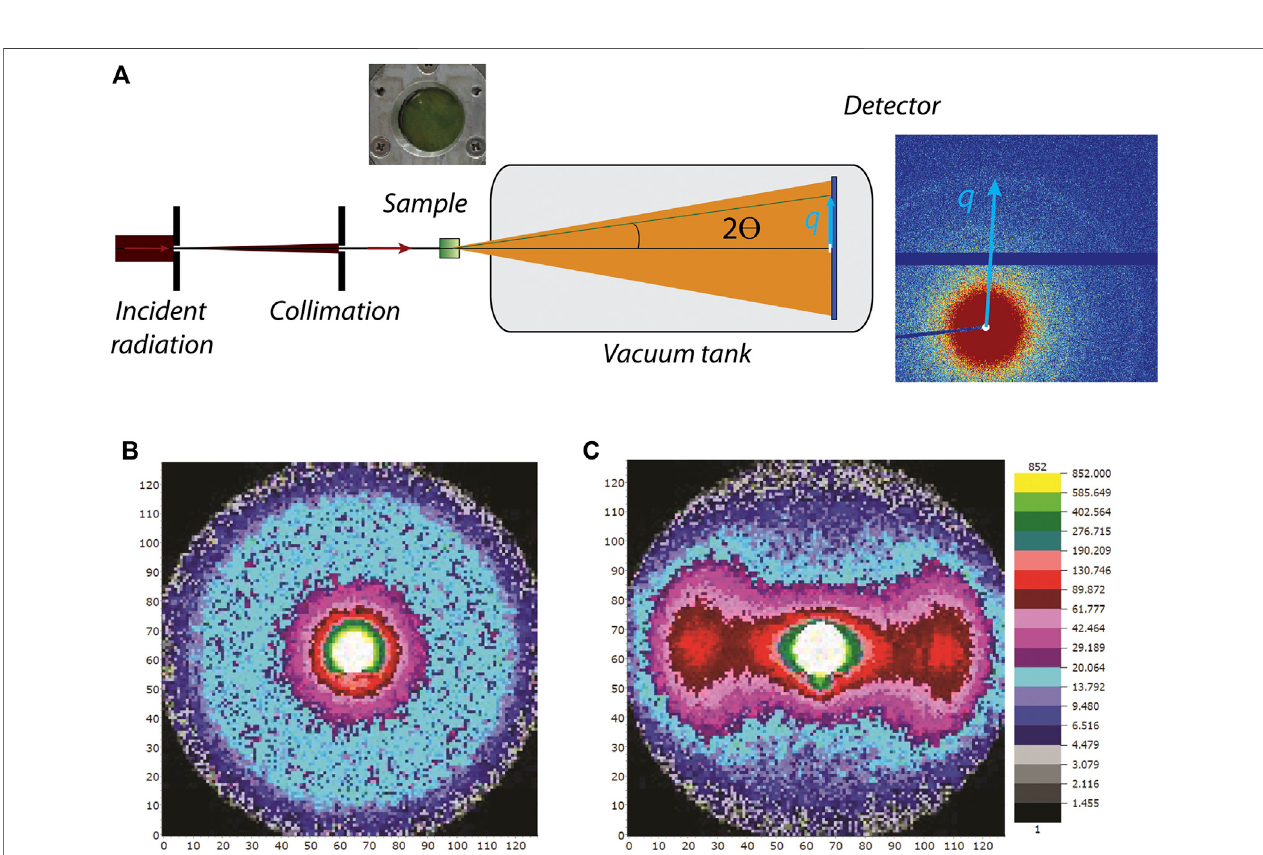
FIGURE 2 | (A) General experimental setup. Incident radiation is collimated and penetrates the sample (green box). Scattering arising in 2 θ direction and the resulting scattering vector q are depicted in light blue. A beamstop (white) blocks the primary radiation. (B) Isotropic 2-dimensional scattering pattern from nonaligned system. (C) Nonisotropic 2-dimensional scattering pattern from a magnetically aligned